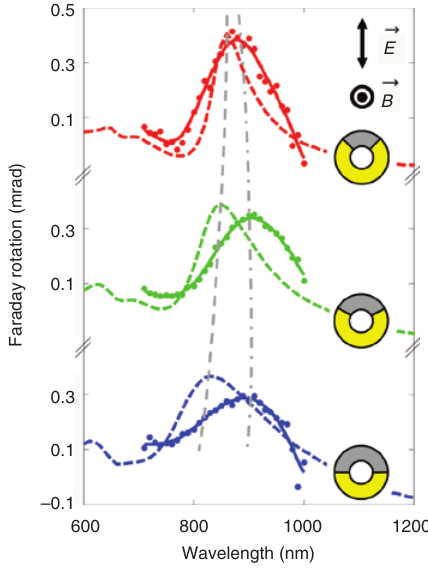
Figure 2: Faraday rotation of polarization azimuth. Dots describe the experimental results for samples with Ni sectors that span over 90 ° (red), 135 ° (green), and 180 ° (blue) in the pres- ence of a 100-mT external magnetic field. Solid lines act as guide for the eye. Dashed lines represent the corresponding computa- tional results when transmission is normalized to the experimental values (see Materials and methods). The dashed grey line follows the peak position of simulation data, as seen in Figure 4A, while dot-dashed line shows the corresponding trend for the experimen- tal